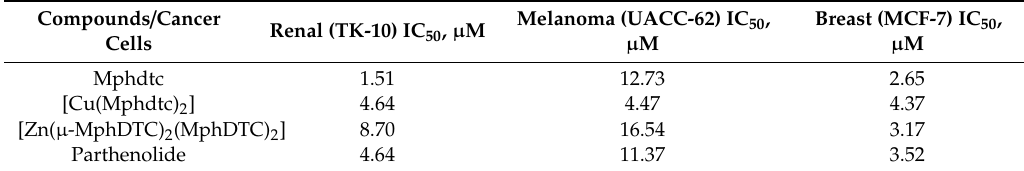
Table 3. Anticancer activities of morpholinyldithiocarbamate (Mphdtc) and the Cu(II) and Zn(II)